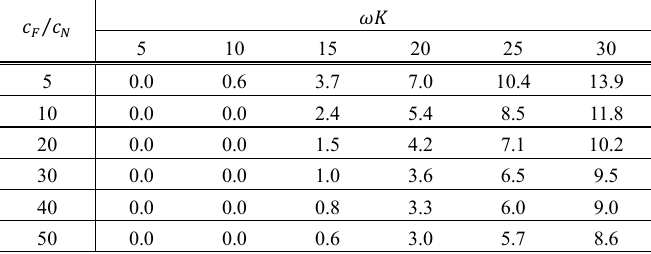
Table 6. Optimal 𝜆𝑇 0∗ when 𝑁 =